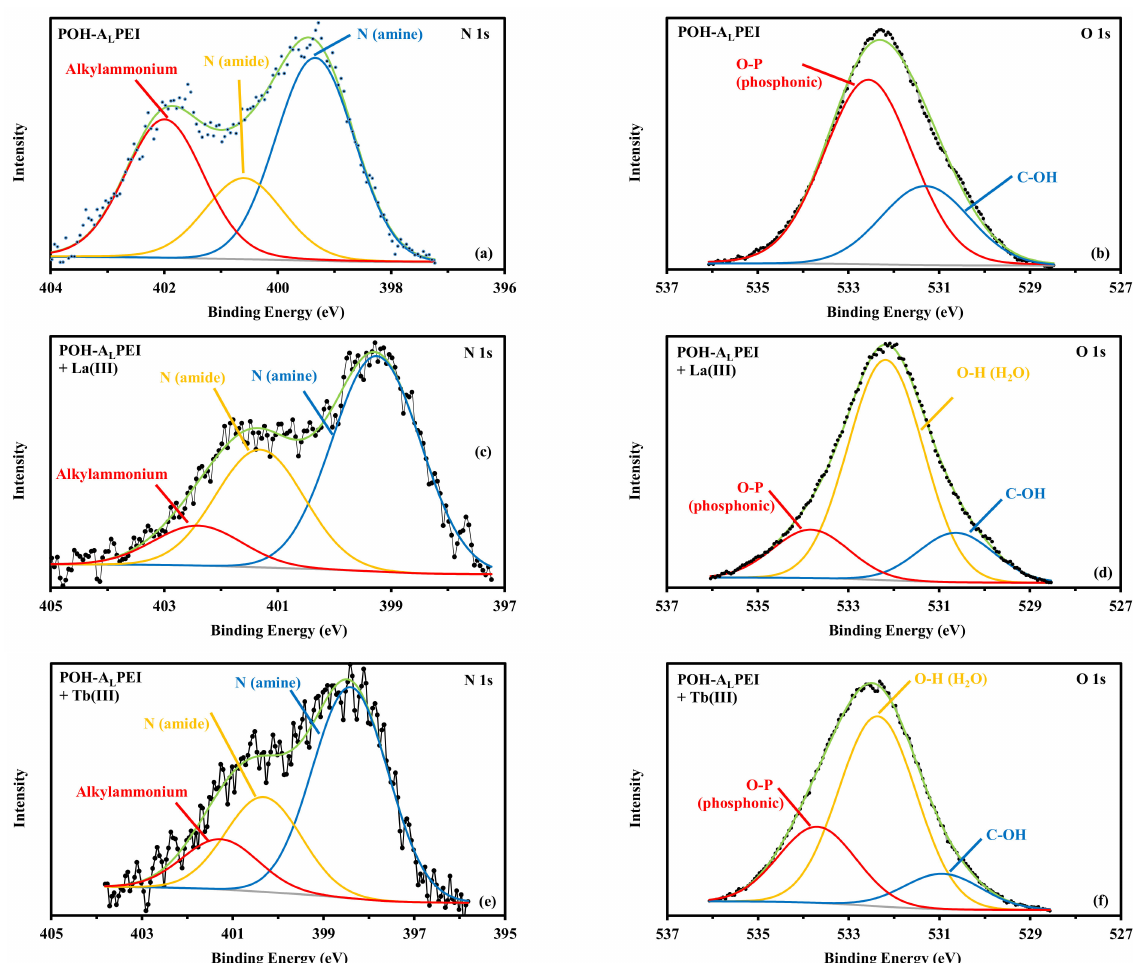
Figure 10. HRES XPS N 1 s ( a , c , e ) and O 1 s ( b , d , f ) core level spectra for POH-A L PEI before ( a , b ) and after metal sorption (La(III): ( c , d ); Tb(III): ( e , f